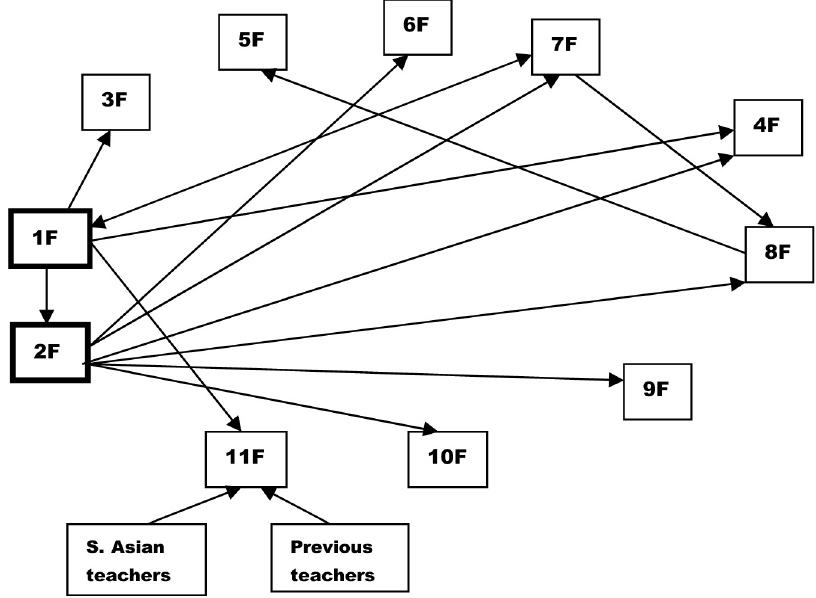
Figure 4: Faban school: Teachers’ views of whom, within the school, had helped and supported